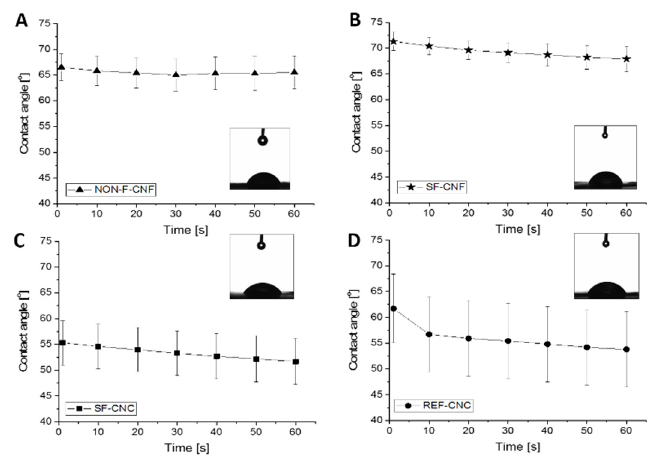
Figure 7. Time dependence of the water contact angles (WCAs) measured on the ( A – C ) DES-pre-treated nanoparticle film surfaces and ( D ) reference CNC film surface. The physical shapes of the water droplets at t = 5 s are provided.